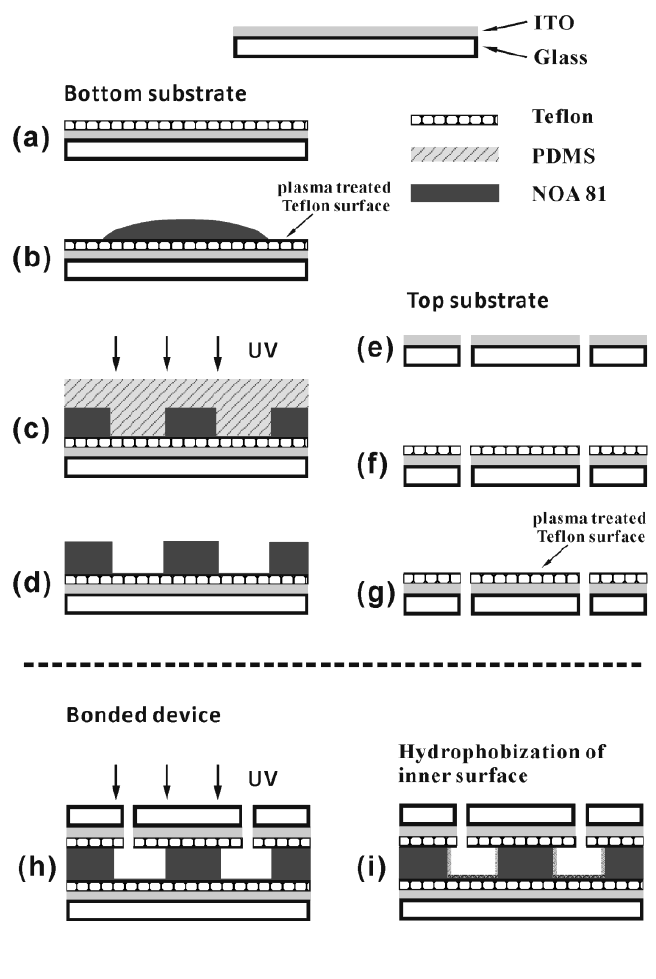
Figure 15. Fabrication process of NOA 81-based microfluidic device. ( a )–( d ) Imprinting NOA 81 as channel structure on a Teflon AF-coated ITO glass slide; ( e )–( g ) Coating Teflon AF on the top substrate with drilled holes for inlet and outlet connections; ( h ) Bonding both bottom and top parts under UV exposure; ( i ) Silanization treatment to modify inner surface hydrophobic. Reprinted from [69] with permission from Royal Society of Chemistry